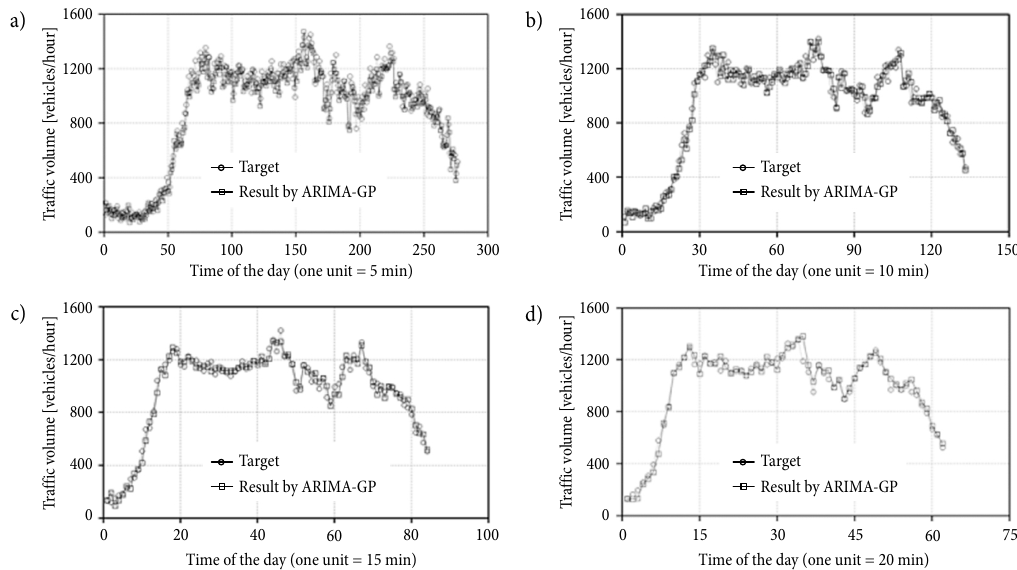
Fig. 10. Prediction results for different aggregation time intervals by using the hybrid method at Site A